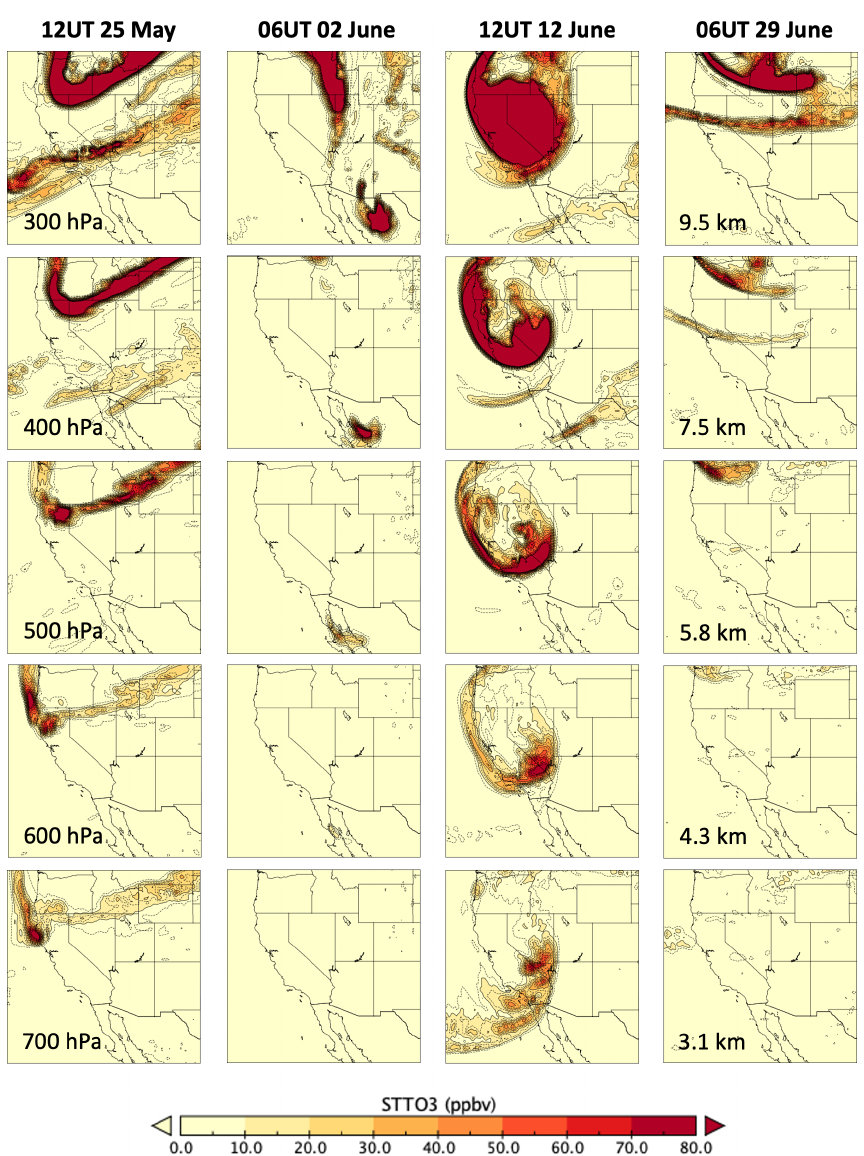
Figure 9. FLEXPART STTO3 tracer distributions during the four IOPs. The plots show the distributions, from left to right, at 12:00UT 25 May, 00:00UT 2 June, 12:00UT 12 June, and 06:00UT 29 June and from top to bottom at 300, 400, 500, 600, and 700hPa. The approximate altitudes above sea level near Las Vegas corresponding to the different pressure surfaces are shown in the panels on the far right. The heavy black contour lines (e.g., in the upper left panel) indicate that the scale is